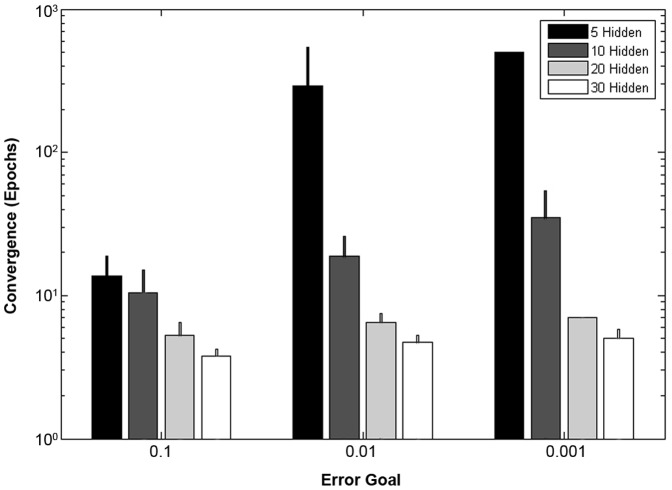
Number of epochs required for convergence to error goal given the number of hidden nodes during training of the neural network with all 16 input variables.